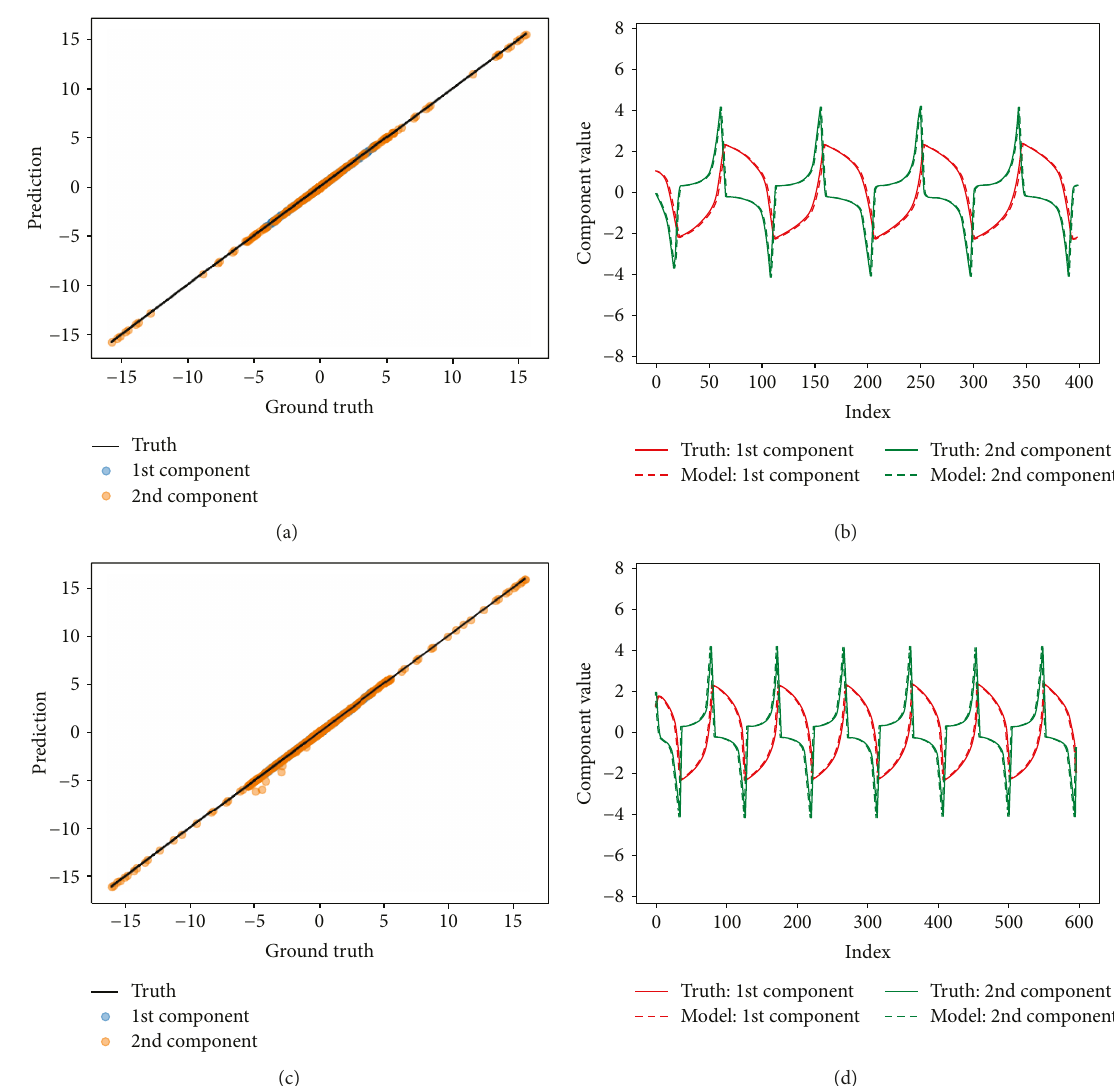
Figure 2: A priori and a posteriori result of the basic model on VDP case. (a, b) Training data. (c, d) Testing data. (a, c) A priori. (b, d) A